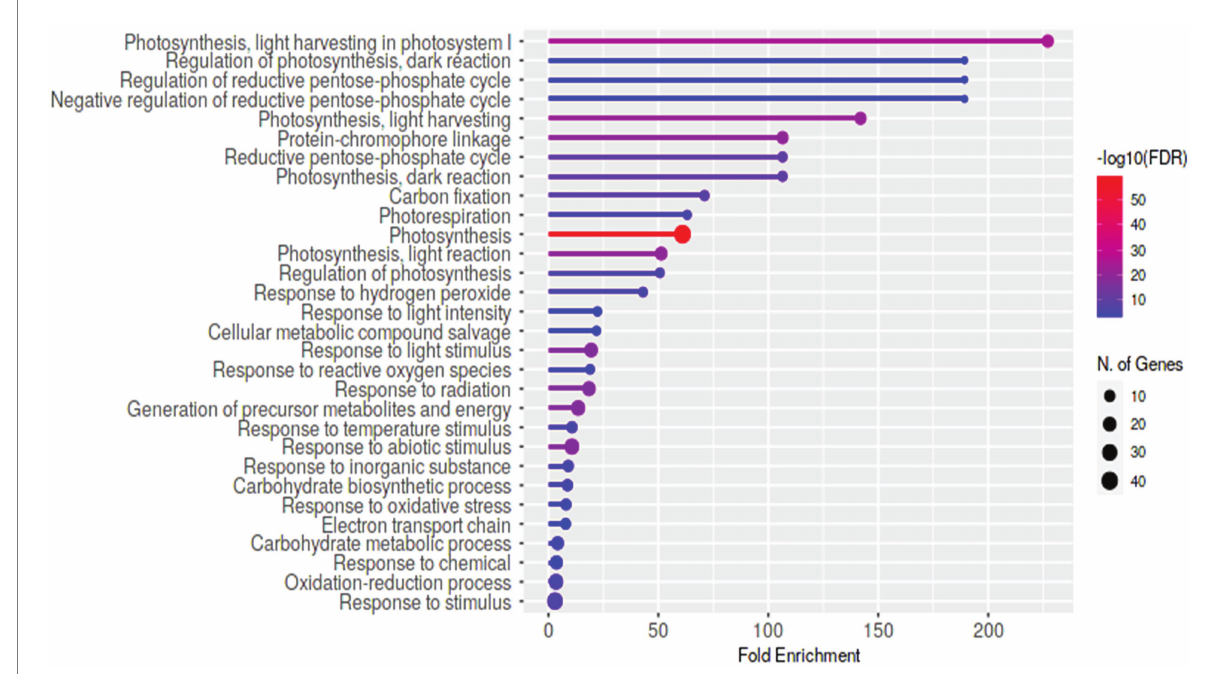
FIGURE 6 The enriched Gene Ontology (GO) terms of the identified 1,278 DEGs commonly detected in the HP lines. The top-ranked GO terms for the down-regulated DEGs in HP lines compared with